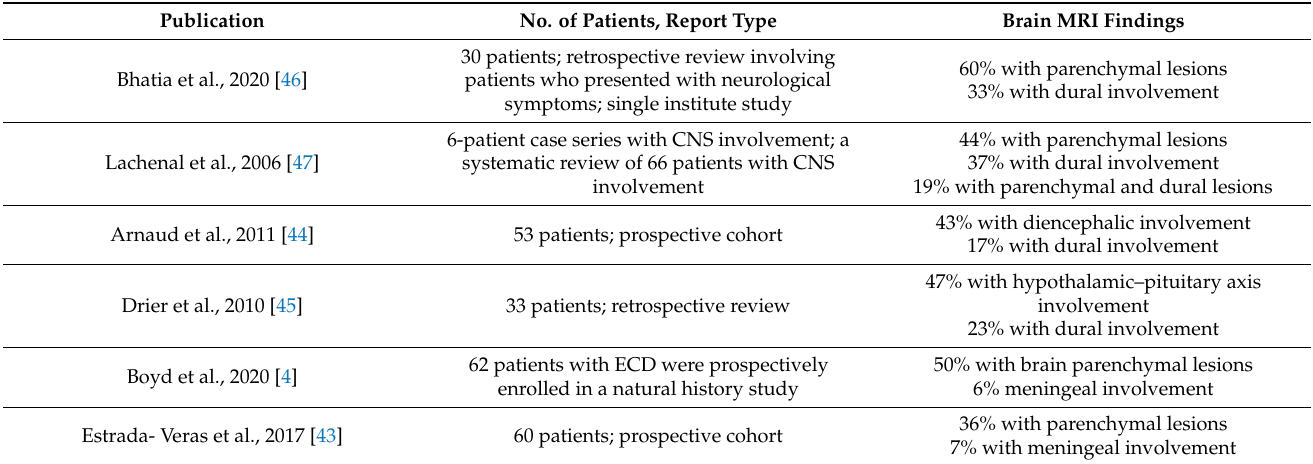
Table 5. Common sites of CNS lesions in ECD as reported in the literature.